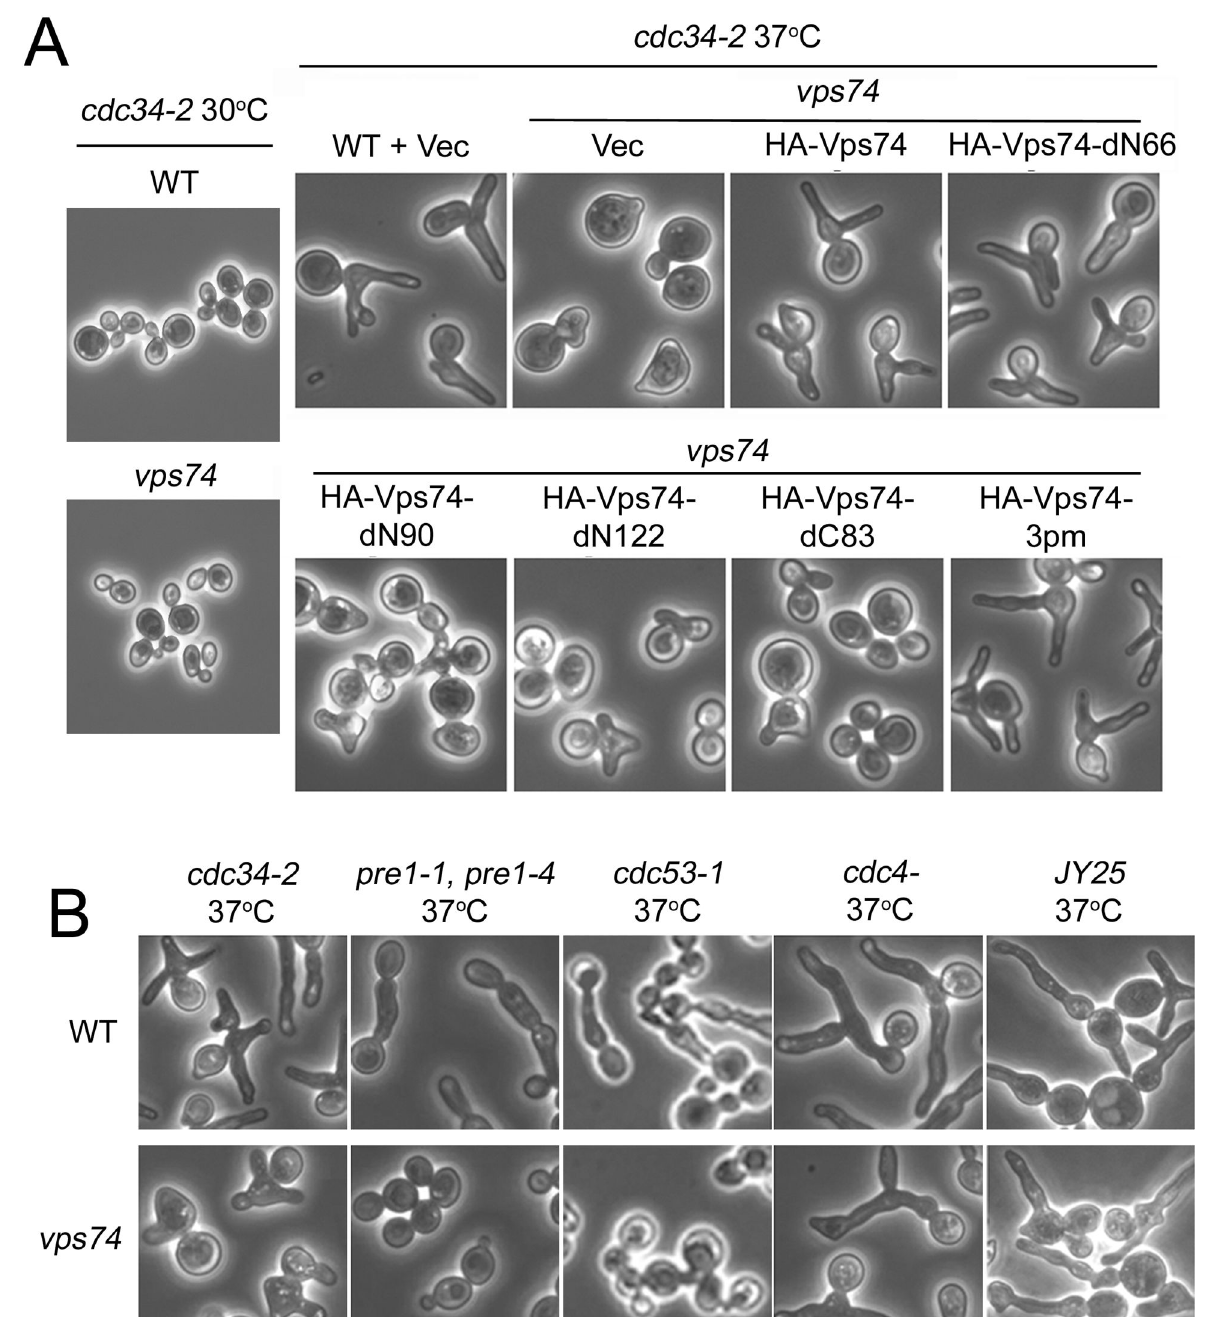
Figure 4. The N-terminal 66 residues of Vps74p are not required for cdc34-2 -dependent apical growth. (A) Morphology transformants carrying the plasmid pVT101U (Vec) in cdc34-2 mutant were detected. Transformed cells were grown in a synthetic selection medium at 25°C for 2 h and then shifted to 37°C for 6 h. Next, the ability to complement the elongating morphology was investigated using microscopy. Cells of cdc34-2 with VPS74 deleted were transformed with the indicated plasmids and then imaged as previously described. (B) Yeast strains cdc34-2 , pre1-1/pre4-1 , cdc53-1 , cdc4 -, JY25 , cdc34-2/vps74 Δ , pre1-1/pre4-1/vps74 Δ , cdc53-1/vps74 Δ , cdc4-/vps74 Δ, and JY25/vps74 Δ were grown to mid-log phase and these cultures were then transferred from room temperature to 37°C for 6 h and fixed at 37°C. The morphologies of these cells were visualized using microscopy.